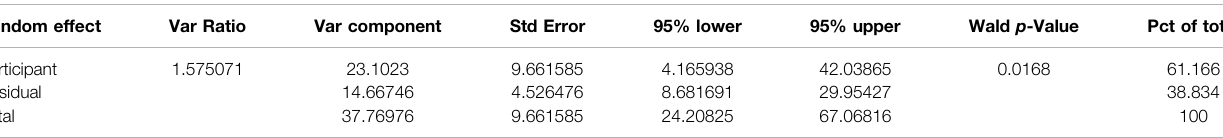
TABLE 5 | IMRT time REML variance component